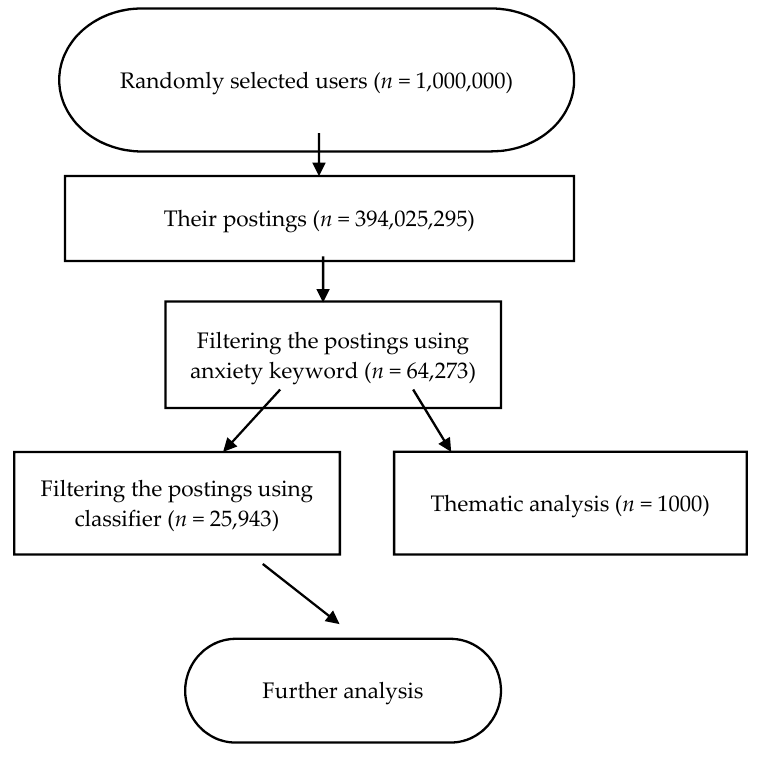
Figure 1. Flowchart of postings related to anxiety.